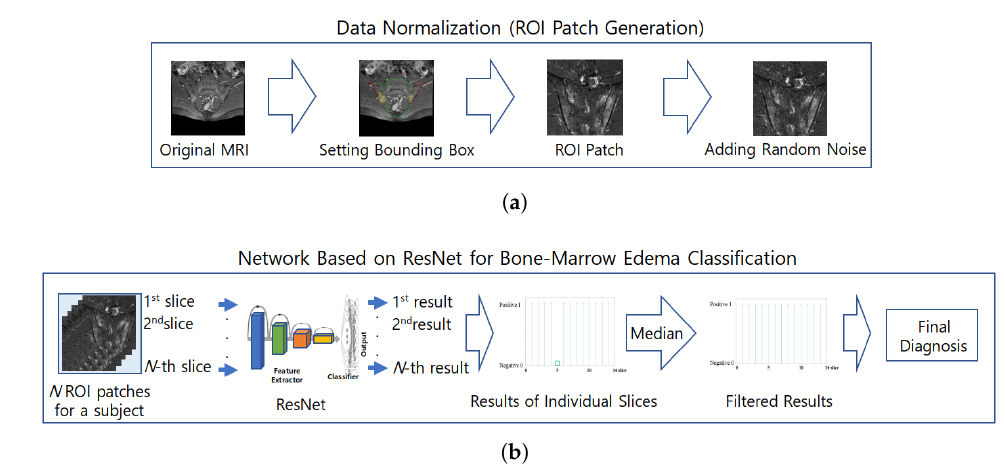
Figure 1. Overall process of the proposed method for diagnosing sacroiliac arthritis. ( a ) Process of ROI generation; ( b ) ResNet based network for Bone marrow edema